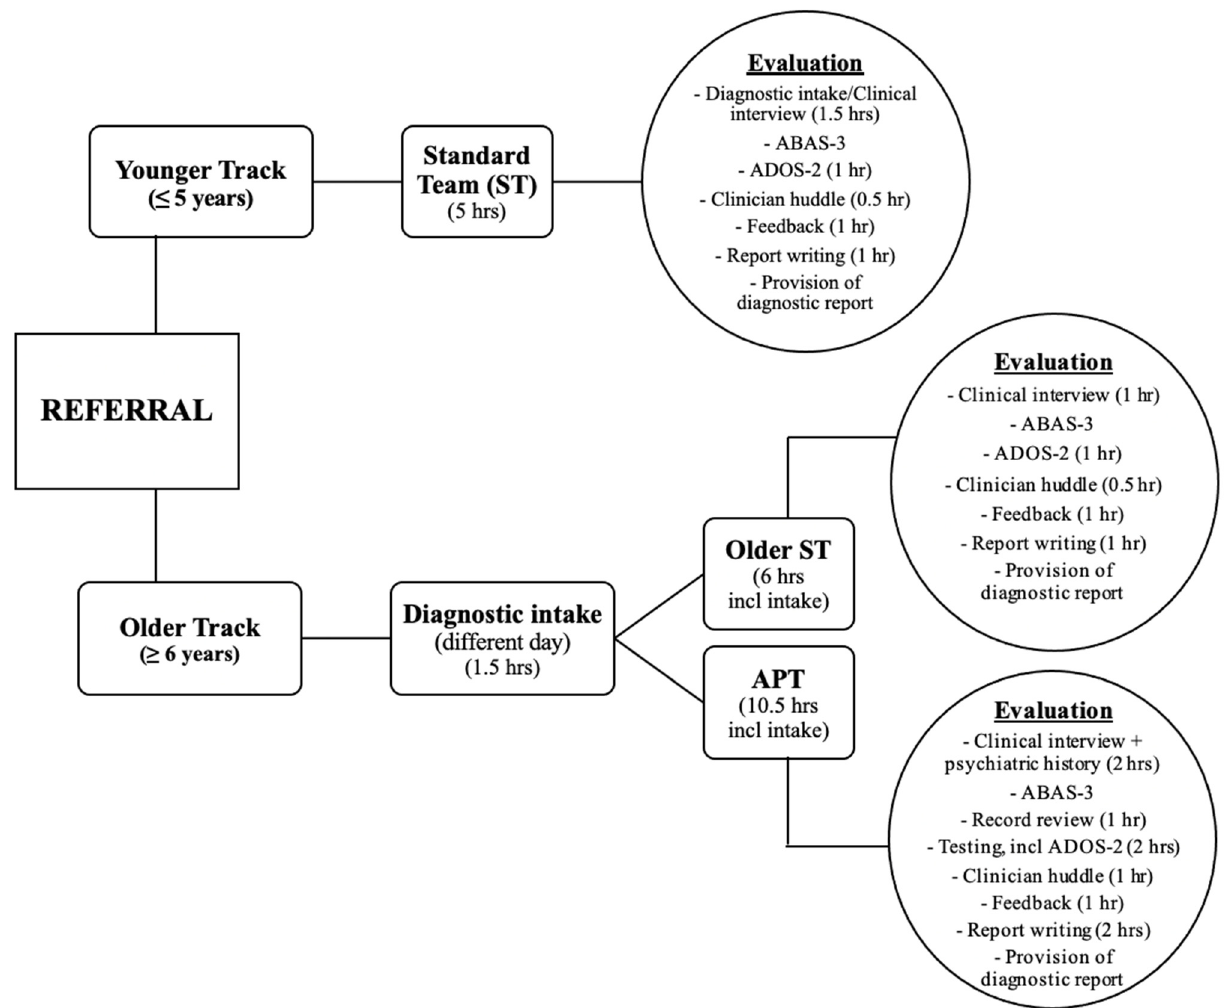
Figure 1. Team evaluation workflow and templated time, describing team evaluation components and templated time for each diagnostic model.